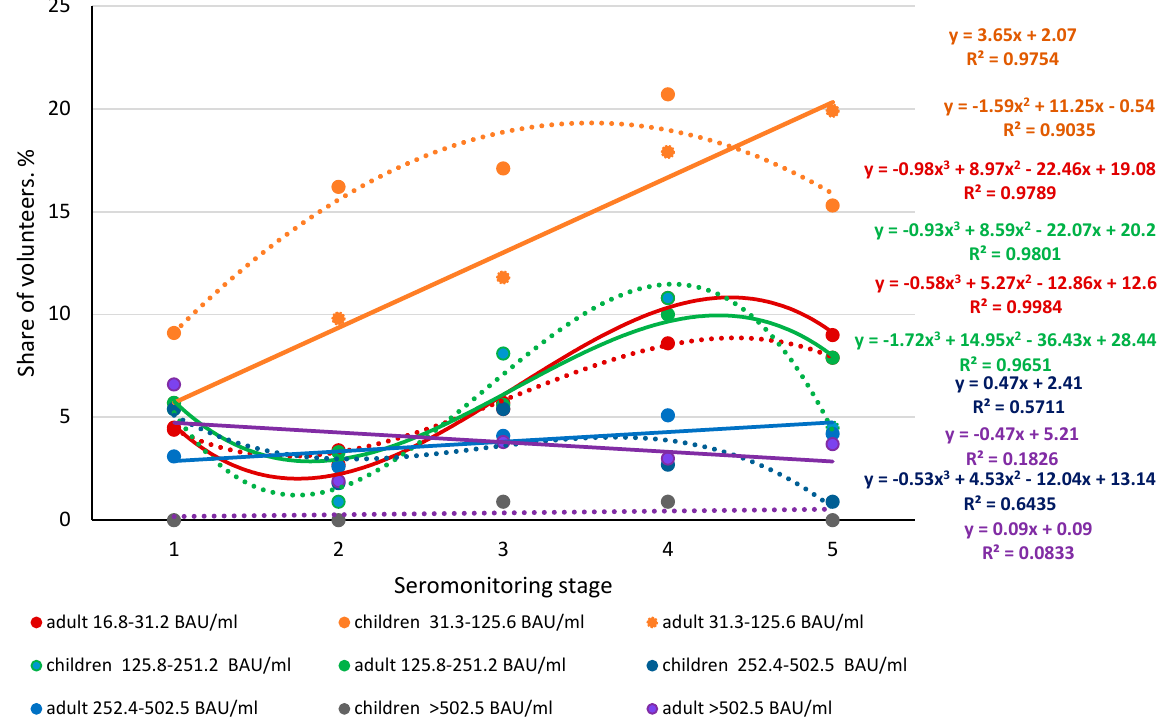
Figure 3. Distribution of anti-Nc antibody levels among children and adults, by seromonitoring stage. Colored lines—dynamics of Ab distribution in children and adults in the dynamics of monitoring; colored dotted lines—trends in Ab levels in children; solid color lines are trends in Ab levels in adults. The equations for the trend curves in their respective colors are shown to the right of the curves and correspond to the sequences in which the end points of the trend lines are located. See additional Table S2.